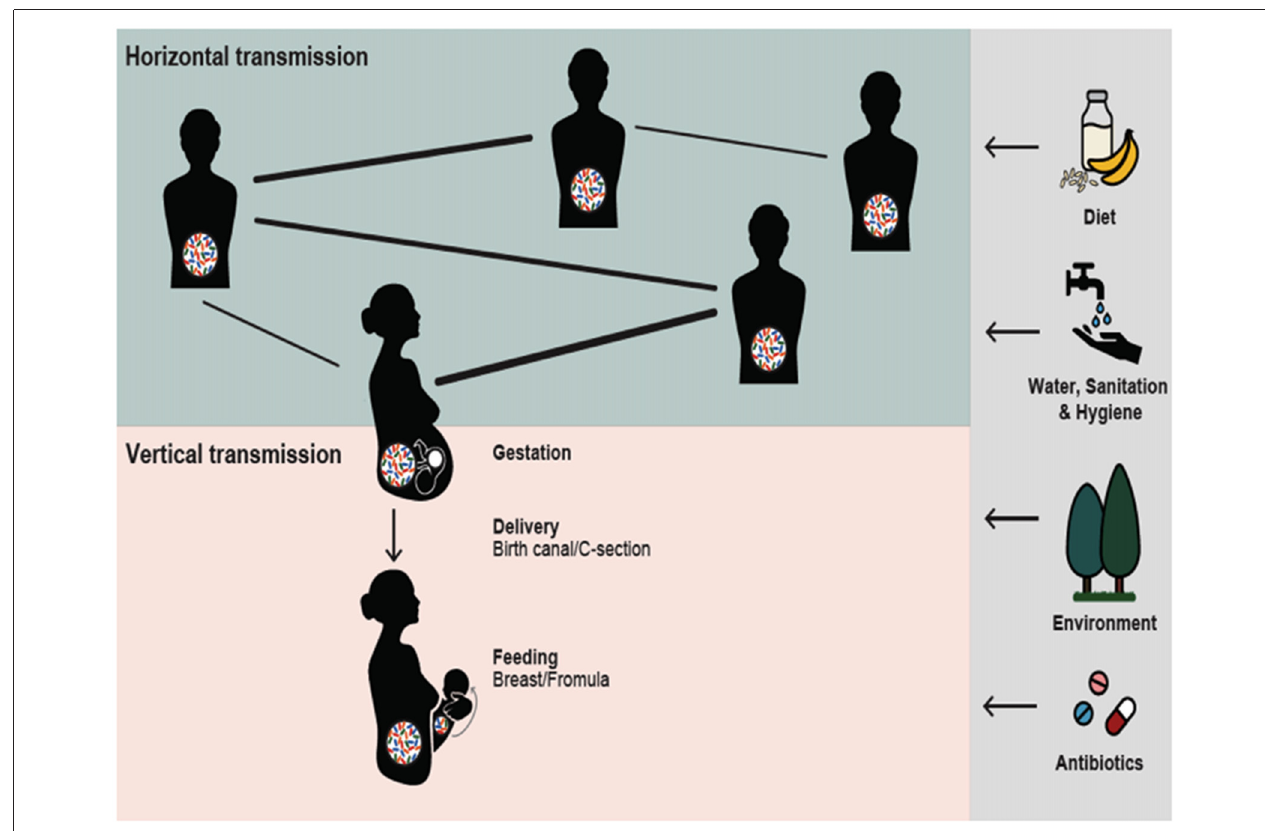
FIGURE 1 | Reciprocal interactions between Gut microbiota (GM) and social structure illustrated for humans. Social interactions may allow for the horizontal GM transmission, presumably in direct relation to the strength of the social bonds (bold lines). Mothers can transmit their microbes vertically to the next generation. In reciprocity, gestation and infancy could be a critical period for the GM to influence infant brain development and future sociability. The nature and quantity of horizontally and vertically transmitted microbes may be influenced by external factors including diet, water, sanitation and hygiene, environment and antibiotic usage; vertical transmission is also influenced by the mode of delivery and method of